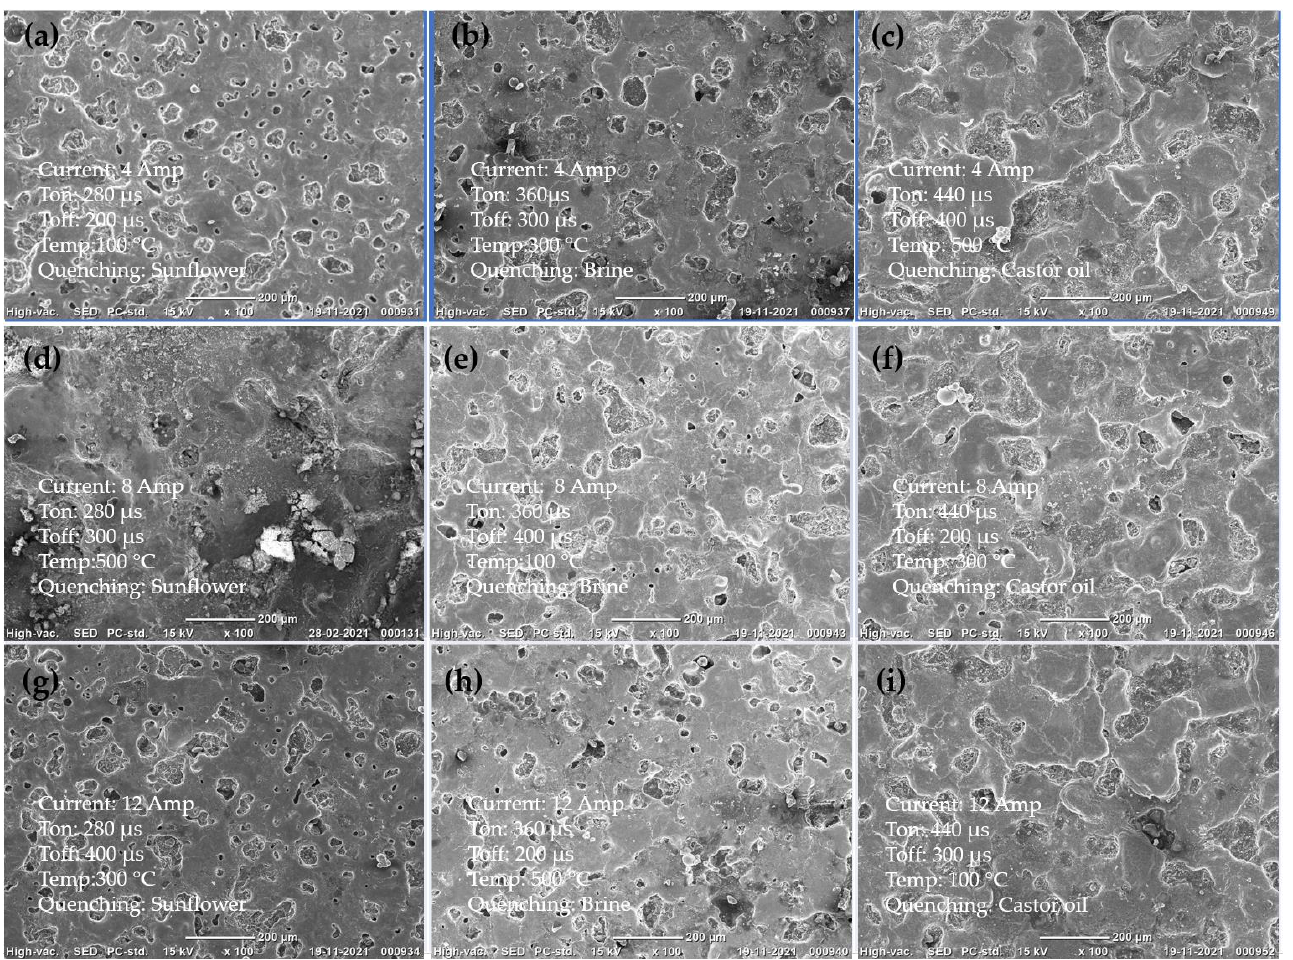
Figure 4. EDC coating Surface observations: ( a ) EX 1, ( b ) EX 2, ( c ) EXP 3, ( d ) EX 4, ( e ) EX 5 and ( f ) EX 6, ( g ) EX 7, ( h ) EX 8 and ( i ) EX 9 (all SEM images are 100X)